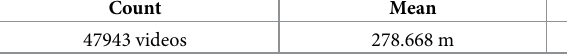
Table 5. A statistical summary of the distance covered in selected videos.